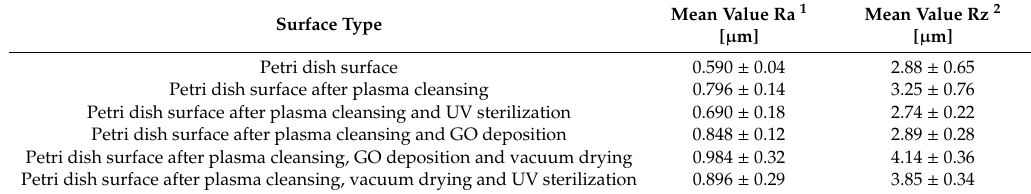
Table 1. Petri dish surface roughness changes (mean out of 10 measurements) with standard deviation.